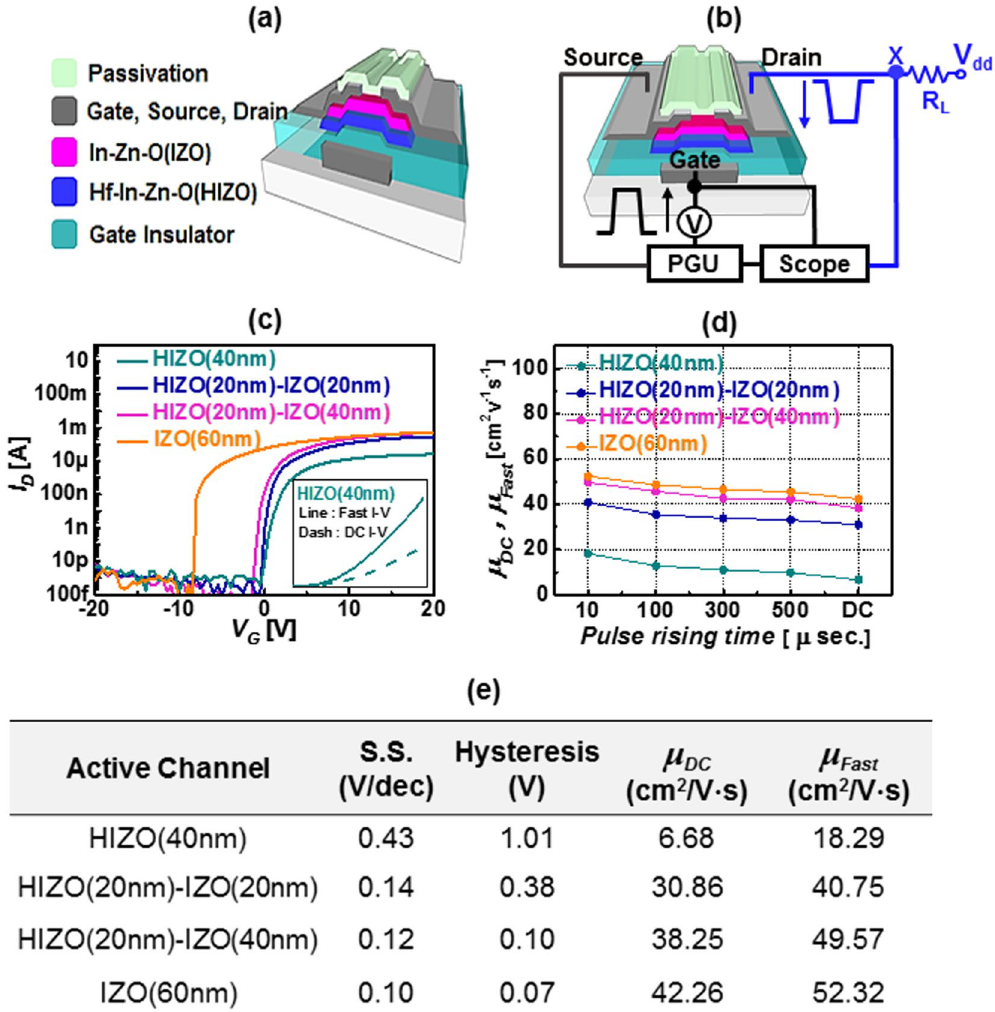
Figure 2. ( a ) Basic schematics of bilayer oxide TFT with bottom gate, top contact, and passivation layer. ( b ) schematic of μ s-FIV/PIV system setup. ( c ) DC I–V characteristics of various oxide TFTs. Inset shows representative fast I–V and DC I–V data for HIZO TFT. ( d ) Extracted mobility versus voltage ramping time for various oxide TFTs. ( e ) Sub-threshold slope, hysteresis, and mobility extracted from DC I–V and fast I–V measurement methods for four different active oxide semiconductor